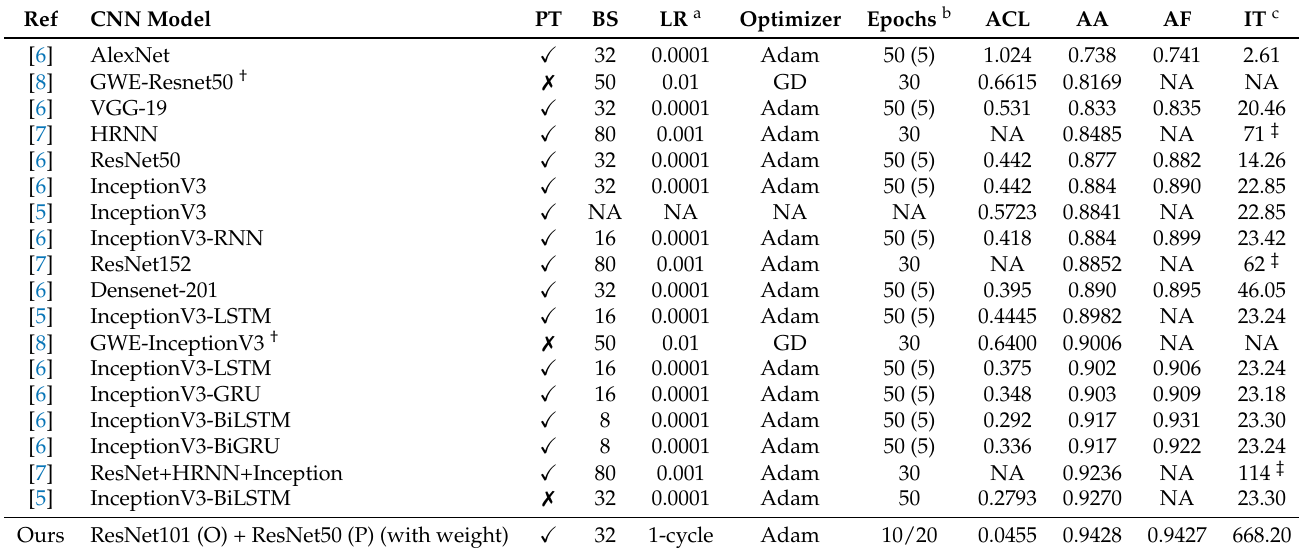
Table 4. Comparison of results with previous studies on AUC-DDD v2 dataset (sorted on average accuracy of the